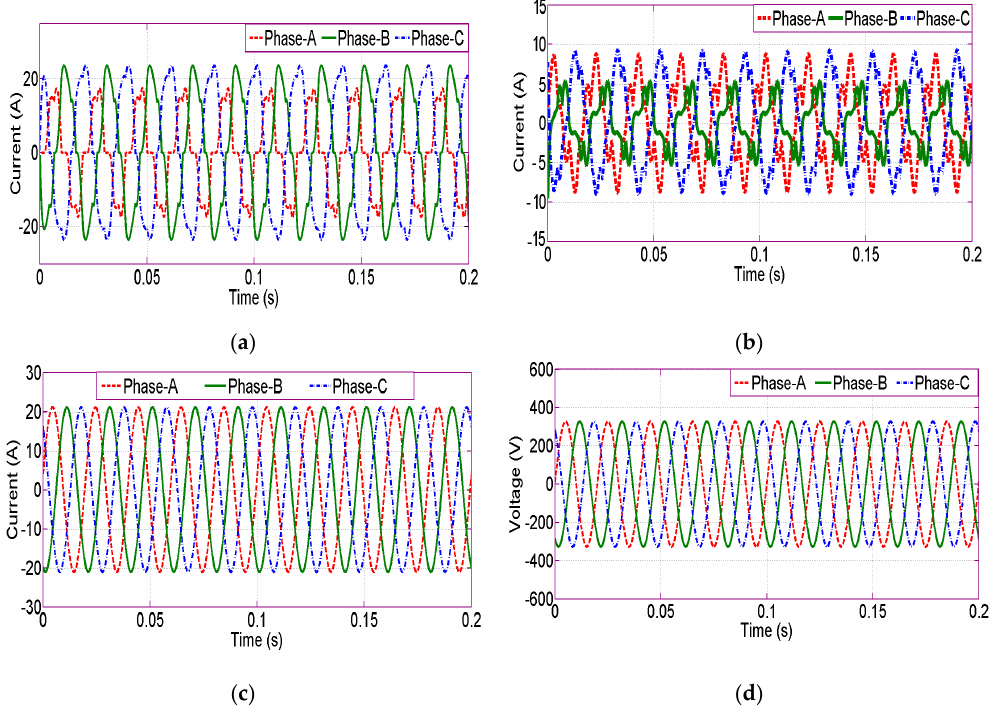
Figure 17. Simulation results under balanced voltages with unbalanced loads: (a) load current; (b) injected compensation current; (c) source current; and (d) source voltage.